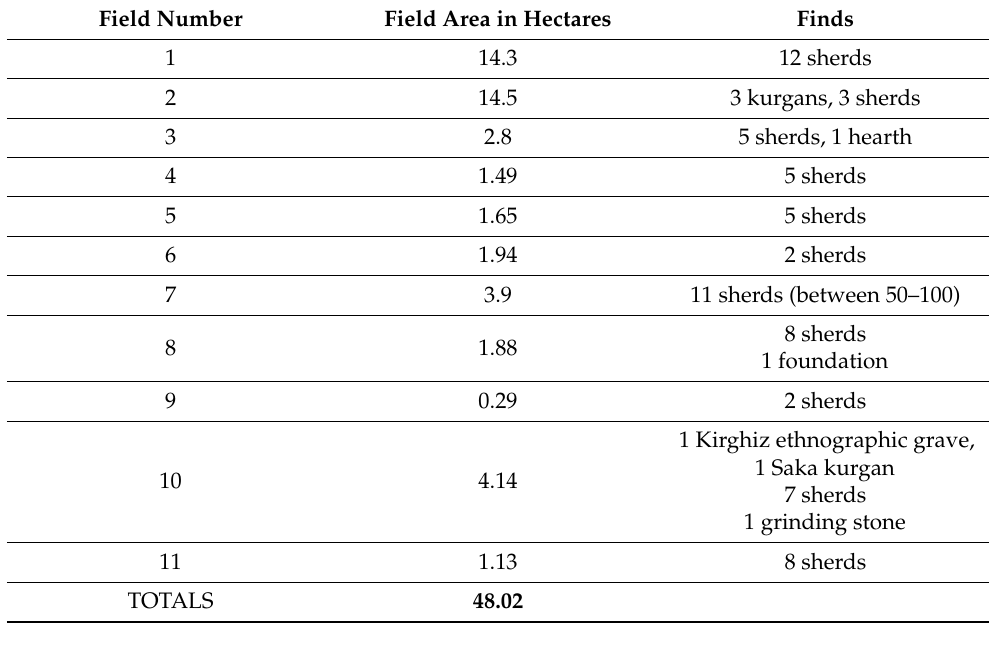
Table 3. Lower Kizil Suu Survey of Agricultural Fields.